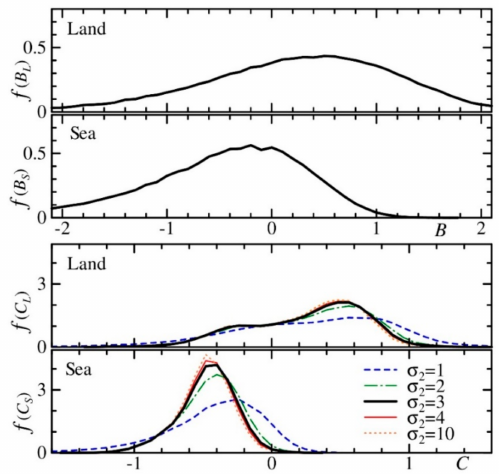
Figure 3. Probability distribution function of B (top two panels) and C (bottom two panels) of pixels on land and sea.